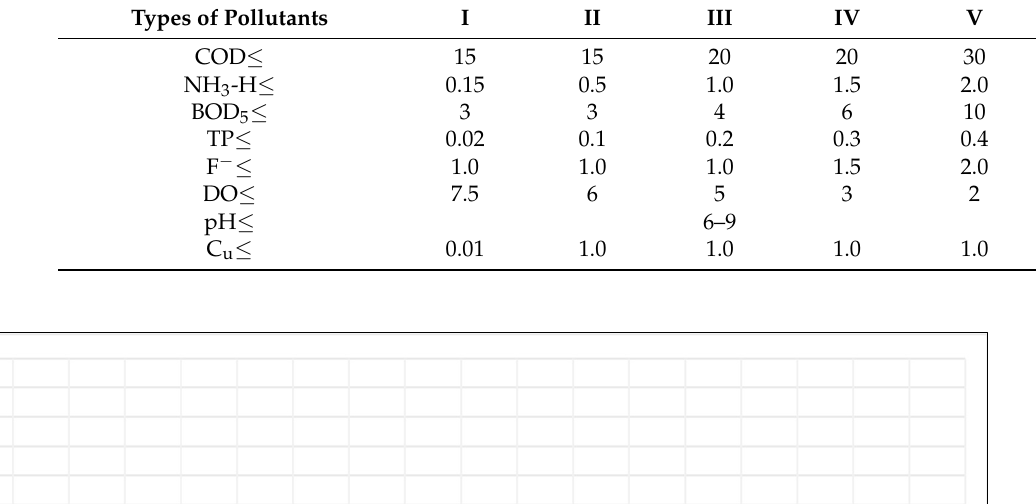
Table 2. Environmental quality standards for surface water in China (mg/L).